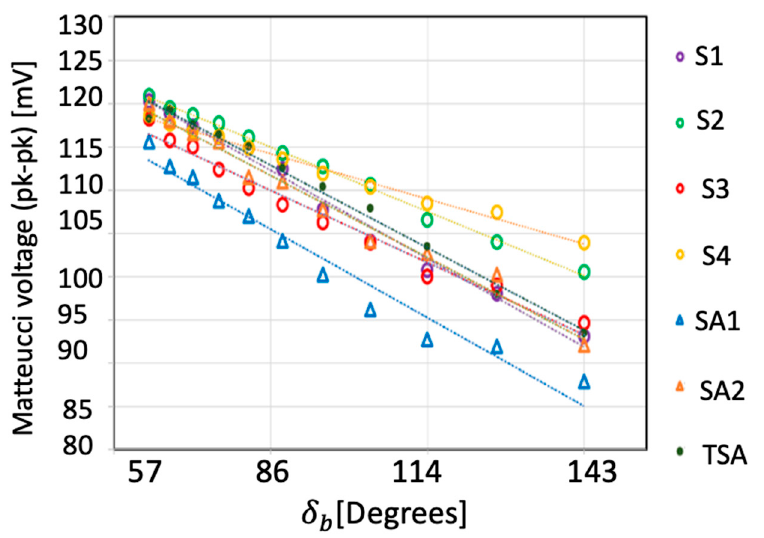
Figure 6. A bending sensor (shaded area) with length L following the contour of an arc of radius R and bending angle δ b .